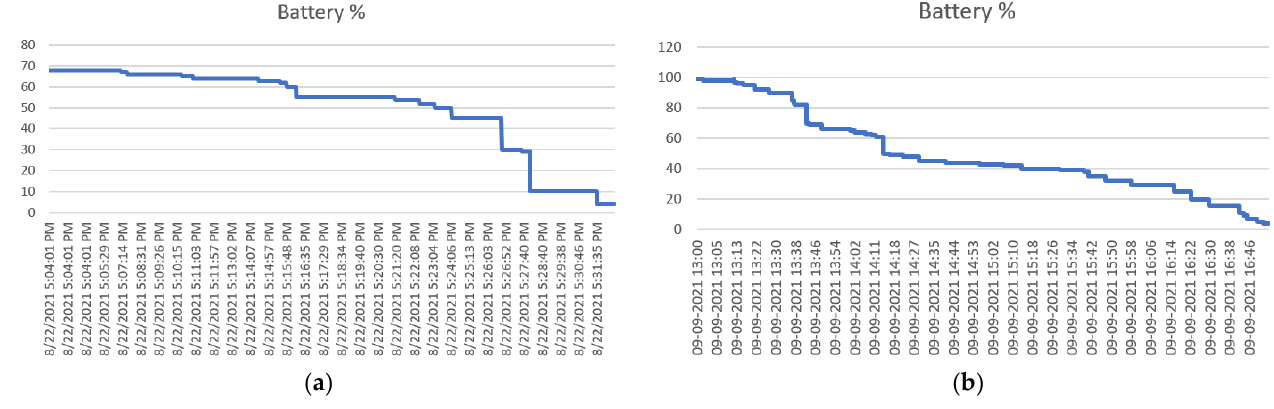
Figure 7. ( a ) Battery Vs. Time; ( b ) Battery Vs.